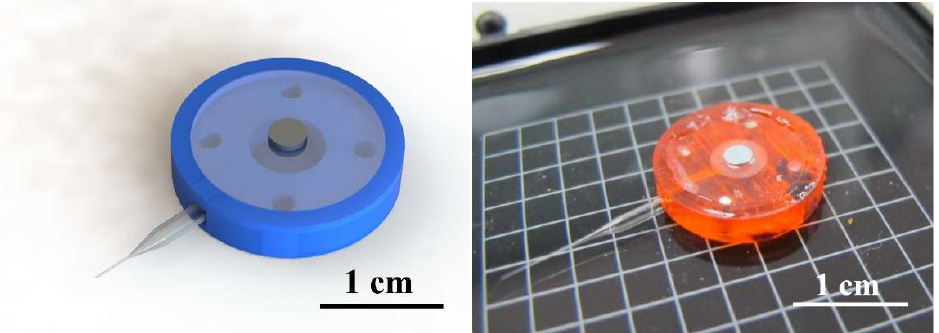
Figure 7. Concept drawing and photograph of the fabricated millirobot.